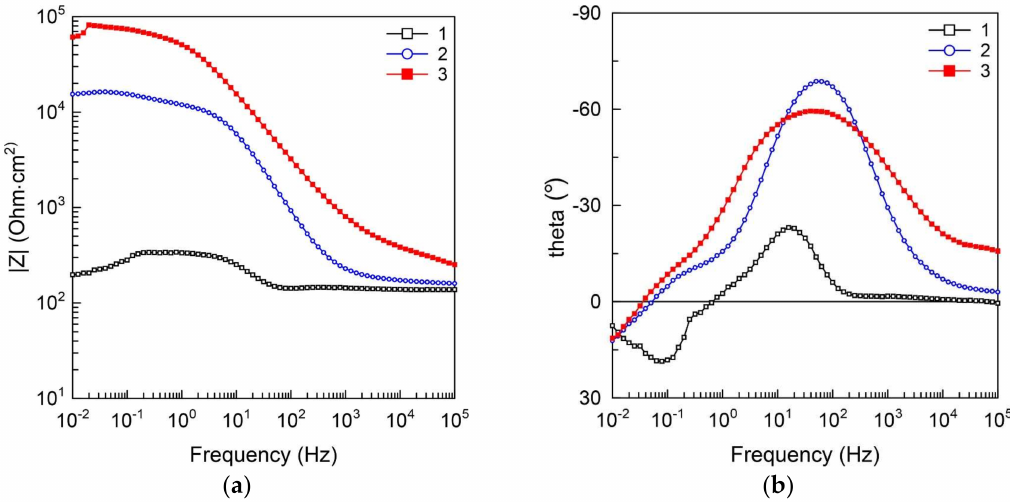
Figure 12. Impedance modulus vs. frequency dependencies ( a ) and phase angle theta vs. frequency dependencies ( b ) obtained in 0.9% NaCl for: 1—bare Mg alloy; 2—CaP coated Mg (350 V, 10 min); 3—CaP coated Mg (450 V, 10